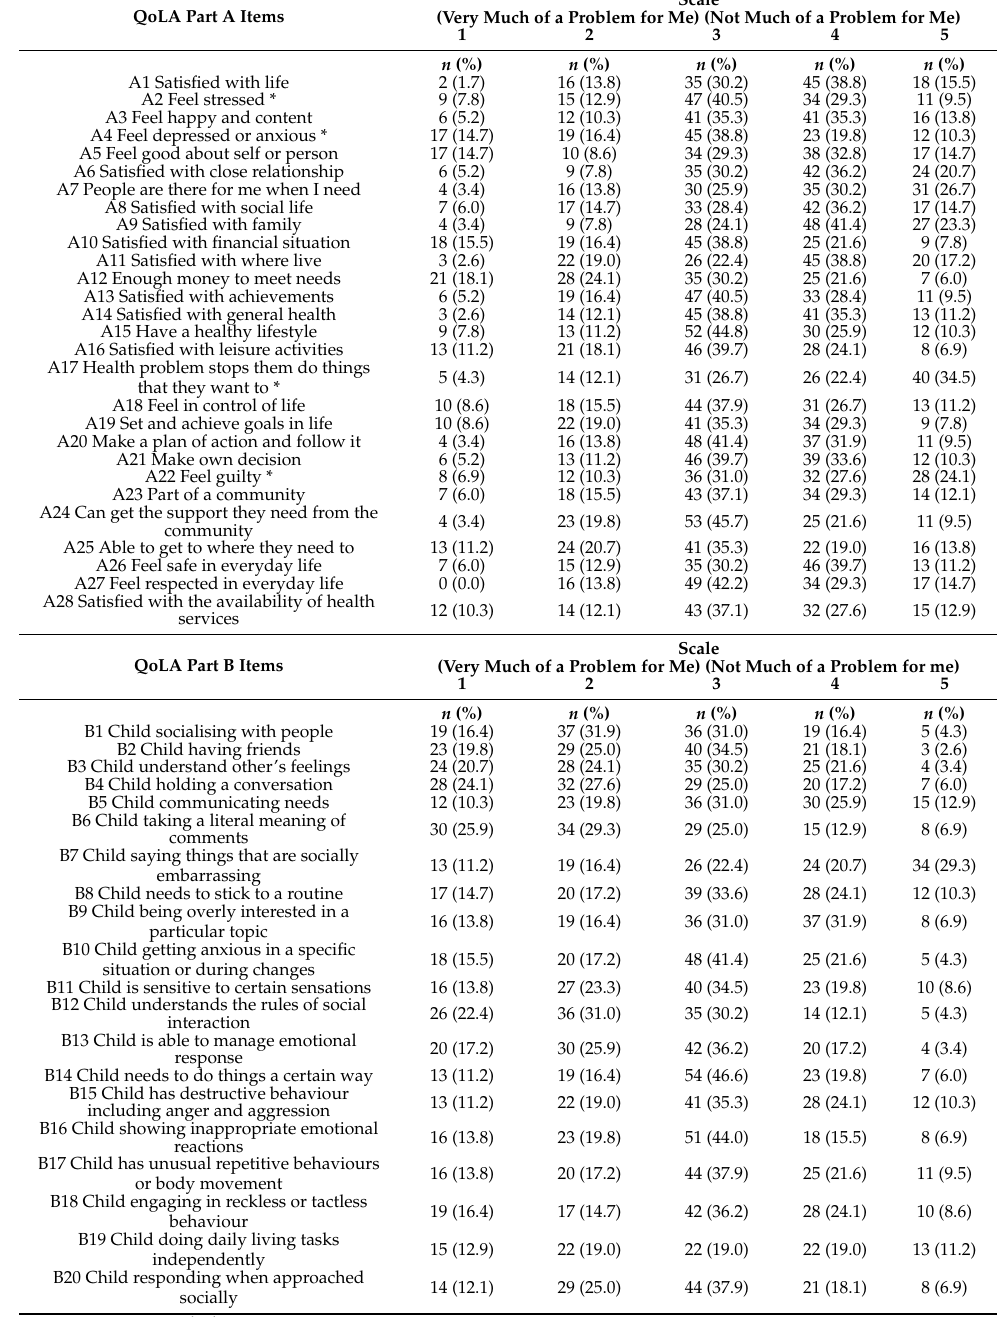
Table 3. Responses of the main caregivers to the Quality of Life in Autism (QoLA) questionnaire for Part A and Part B ( n =